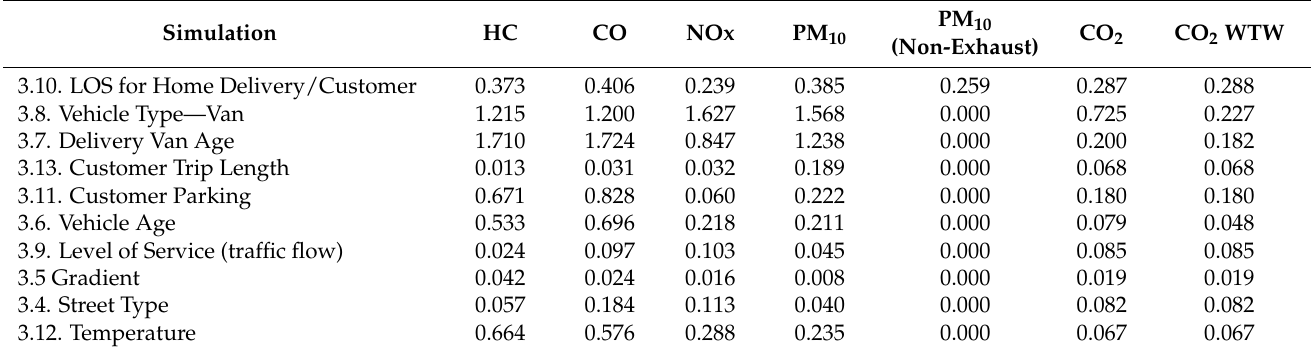
Table 4. Average coefficient of variance.